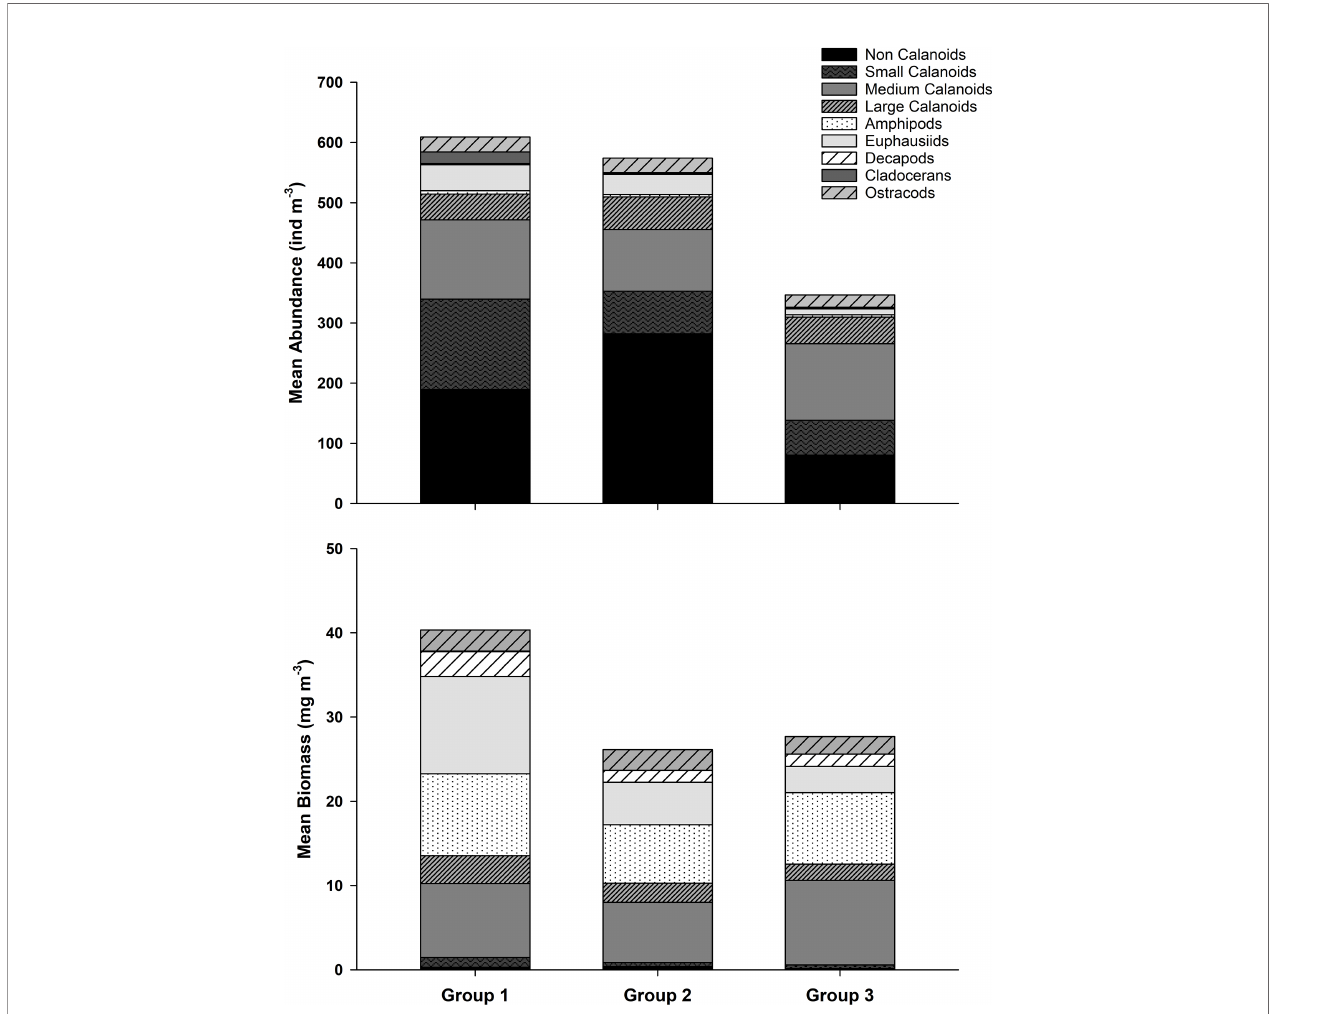
FIGURE 10 | Mean abundance and biomass of the main crustacean taxa in Groups 1, 2, and 3 from the clustering analysis for the Central Strait of Georgia from 2003-2016. Years with fewer than 3 months of data (2006, 2011, 2012) were excluded from the